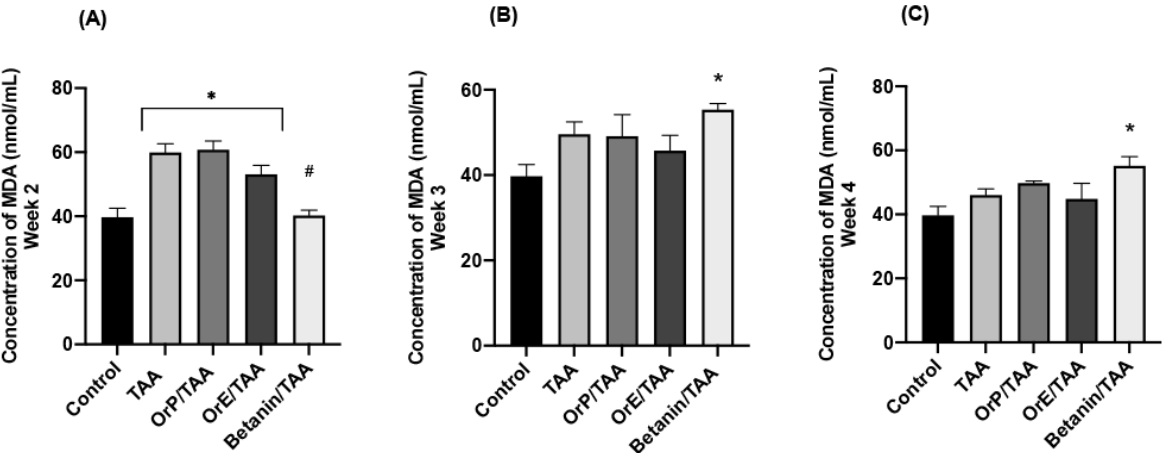
Figure 6. Concentrations of malondialdehyde (MDA) for the different treatments at different evaluation times. ( A – C ) OrE lowers malondialdehyde levels more effectively than OrP. One-way ANOVA with Tukey’s post hoc test. * p < 0.05 compared to control group, # p < 0.05 compared to TAA group.